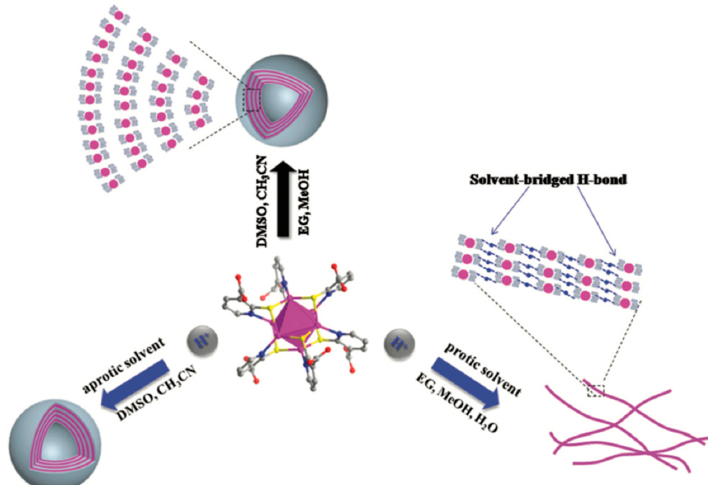
Figure 6. Schematic representation of the building block of Ag 6 -NC for the morphological evolution process controlled by molecular structure and solvents into vesicles and nanowires. Adapted with permission from Ref. [46]. Copyright (2017) Royal Society of Chemistry.